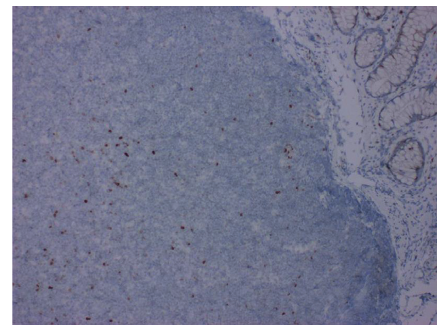
Figure 4: Lymphoid aggregate negative for cyclin D1.